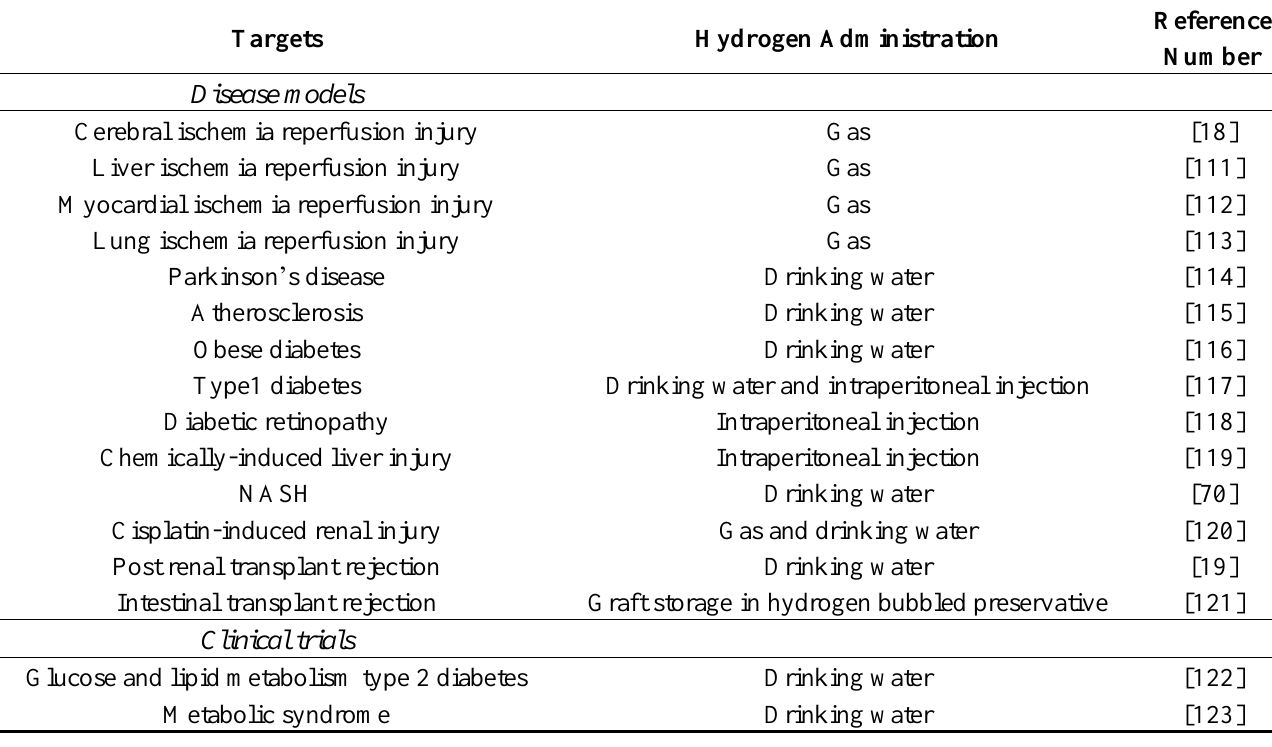
Table 1. Effectiveness of